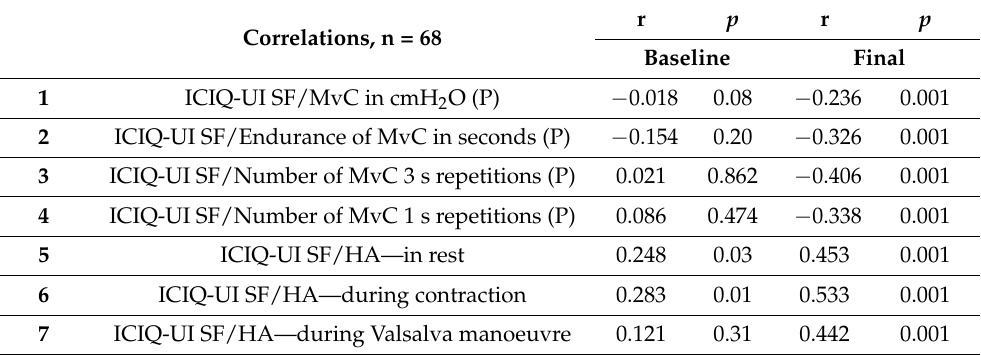
Table 3. The correlation between the ICIQ-UI SF score and pelvic floor muscle function and mor- phometry before and after treatment.